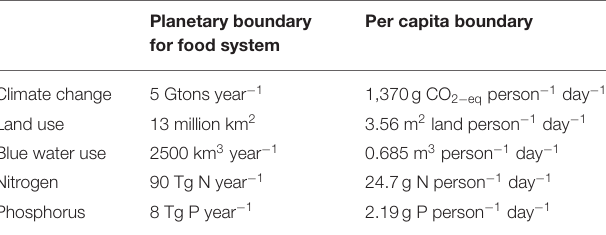
TABLE 1 | Global planetary boundaries for the food system alone (Willett et al., 2019), and per capita boundaries calculated assuming a population of 10 billion people in